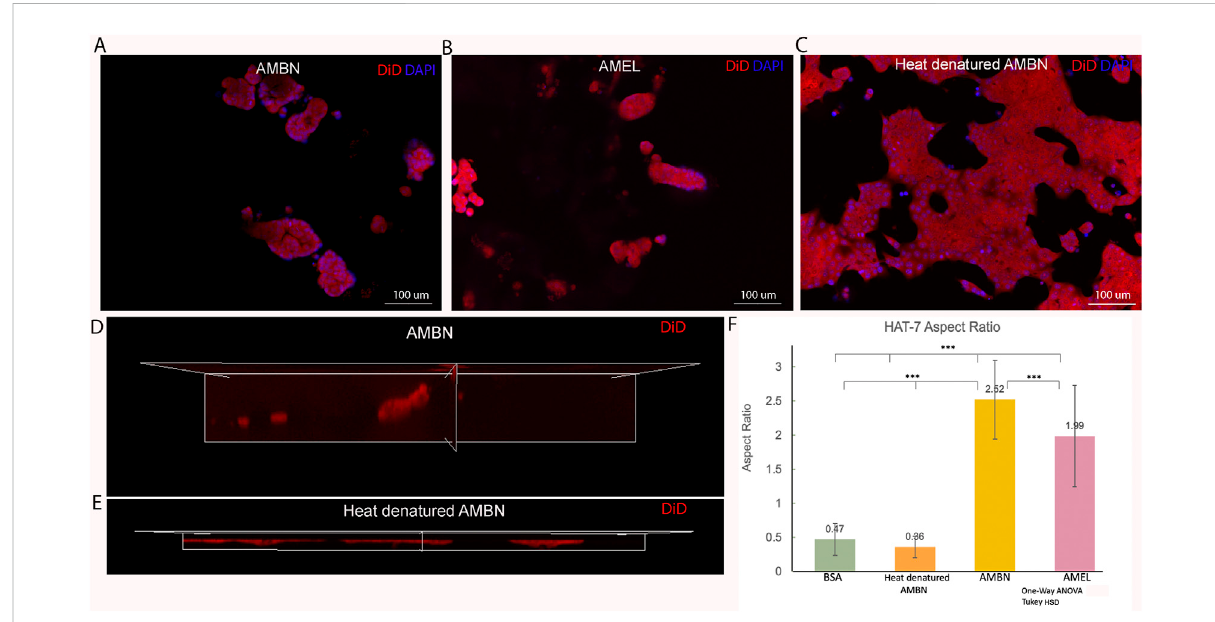
FIGURE 2 HAT-7 cells in modi fi ed 3D-on-top culture using growth-factor reduced Geltrex; 24h. (A – C) . 2D surface images (top view, XY plane) of HAT-7 cells in the presence of AMBN, AMEL and heat denatured AMBN (negative control) respectively. Cell membrane labeled with DiD (red) and nucleus withDAPI(blue).HAT-7cellsorganizeintodistinctcellclustersin (A) and (B) unlikeinthecontrol (C) wherethecellsarespreadalongtheXYplane. (D , E) . 3D reconstruction and axial view (side view, XZplane) of representative samples from AMBN and heat denatured AMBN groups respectively. Cell outline as visualized by DiD reveals elongated, tall cells in (D) unlike the planar, fl at cells with (E) . (F) Aspect ratio measurements of HAT-7 cells from test and control groups. HAT-7 cells are statistically signi fi cantly elongated in the presence of AMEL and AMBN. * p < 0.05; ** p < 0.01; *** p <